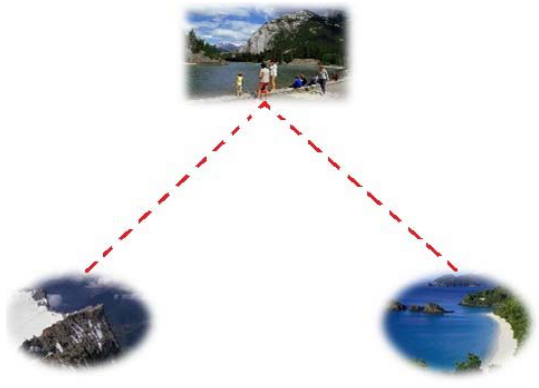
Fig. 5. Composition of objects suggest that input image can be associated with mountains and beach